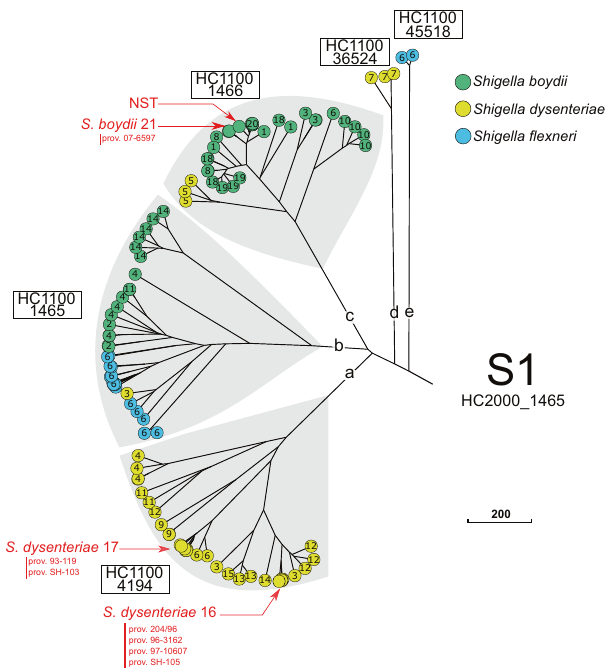
Fig. 2 A NINJA NJ GrapeTree showing the population structure of the Shigella S1 cluster (HC2000_1465). This subtree is based on the tree shown in Fig. 1. The tree nodes are colour-coded by serogroup. The numbers within nodes indicate the serotype. HC1100 designation is indicated next to each subcluster. Novel and provisional (prov.) Shigella serotypes are also shown. NST non-serotypeable. The scale bar indicates the number of cgMLST allelic differences.